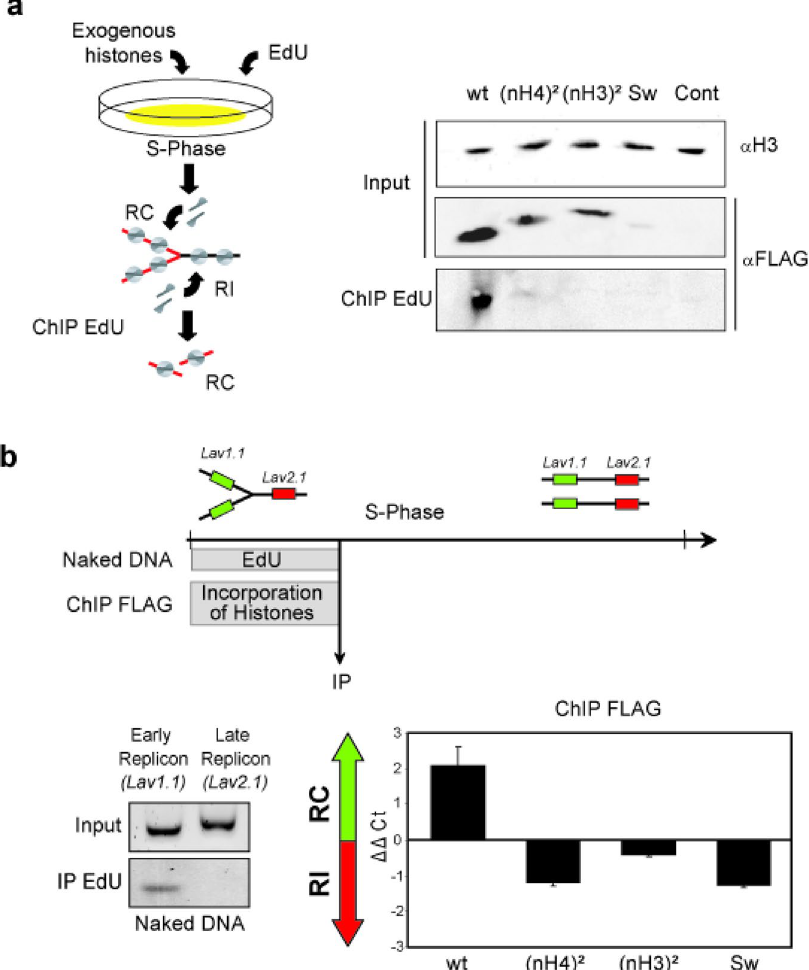
Figure 5. Replication-coupled chromatin assembly requires properly positioned amino-tail domains for transferring H3/H4 from the nuclear import chaperone to the chromatin assembly complex. ( a ) Chromatin assembly in the S-phase occurs by replication-coupled and replication-independent chromatin assembly, which can be discriminated by EdU pulse as depicted in the diagram. Following exogenous H3/H4 complex incorporation, click reactions were performed to couple biotin to EdU and ChIP was carried out with avidin. Crosslinks of immuno-precipitated chromatin were reversed and proteins analyzed by Western blotting. Input fractions were examined with anti-H3 antibody (H3) and anti-FLAG antibody (FLAG), respectively. Immuno-precipitated fractions (ChIP EdU) were examined with anti-FLAG antibody (FLAG). ( b ) Replicon- specific analyses of the H3/H4 tail requirement in replication-coupled chromatin assembly and in replication- independent chromatin assembly. The top diagram represents the experimental strategy for examining replication-coupled and replication-independent chromatin assembly at specific loci. (Left gels) Physarum was pulsed for 1 h with EdU and replicated DNA was isolated by IP with avidin. Immuno-precipitated DNA was analyzed by PCR with primers specific to Lav1.1 (early replicon) and Lav2.1 (late replicon), respectively. (Right graph) Following exogenous complex incorporation, ChIP analyses were carried out using anti-FLAG antibody and qPCR with primers specific to the early replicon ( Lav1.1 ) and the late replicon ( Lav2.1 ), respectively. The graph represents the ΔΔ Ct = Δ Ct (ChIP Late replicon normalized) −Δ Ct (ChIP Early replicon normalized) for the different exogenous complexes. Value > 0 corresponds to preferential replication-coupled chromatin assembly (RC) and values < 0 corresponds to preferential replication-independent chromatin assembly (RI),